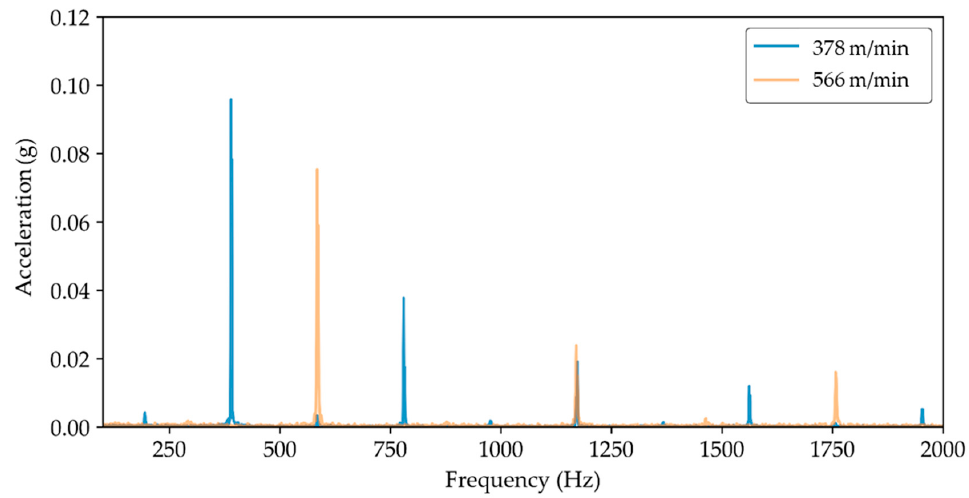
Figure 4. Fast Fourier Transform of the part acceleration signal for test at fz = 0.1 and ap = 1.0 mm, under two different cutting speeds.